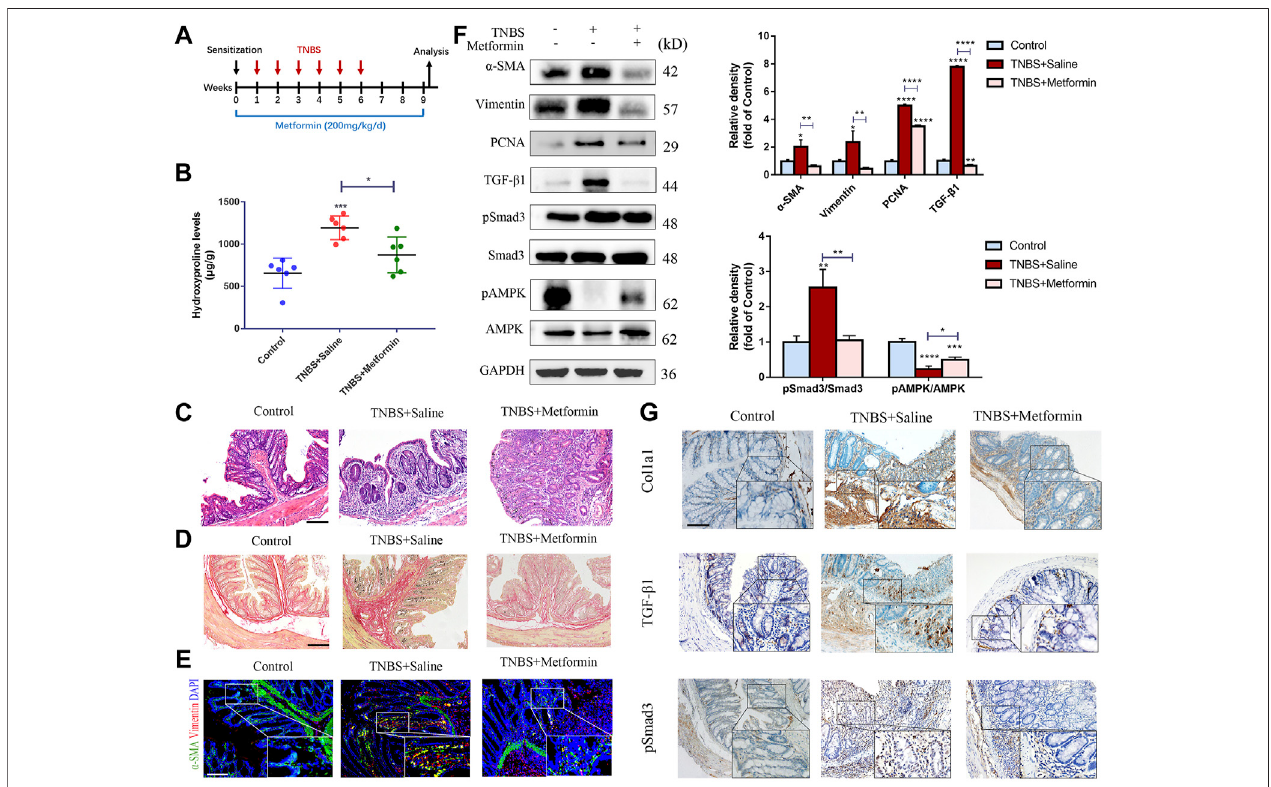
FIGURE1| Preventivemetforminapplicationdecreasesintestinal fi brosisinTNBSmicemodel. (A) MiceexperimentalprotocolofTNBScolitis. (B – D) Colontissues werestudiedby (B) Hydroxyprolineassay, (C) H&Estainingor (D) SiriusRedstainingatweeknine exvivo ( n =6/group). (E) IFfor α -SMAandVimentinwereconductedin colon sections of three groups ( n = 6/group). (F) Representative images of western blot showing changes of the key fi brotic markers and proteins in TGF- β 1/Smad3 pathway after metformin treatment. Quantitative analyses of western blot ( n = 3 independent experiments) were shown (G) Representative micrographs of immunohistochemical staining for Col1a1, TGF- β 1 and pSmad3 in colon specimens. Scale bars, 100 μ m. Quantitative results were analyzed by one-way ANOVA test. * p < 0.05; ** p < 0.005; *** p <